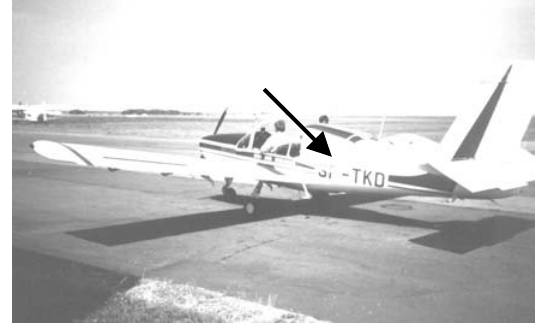
Fig 2. The experimental plane. The position of the system inside the fuselage is